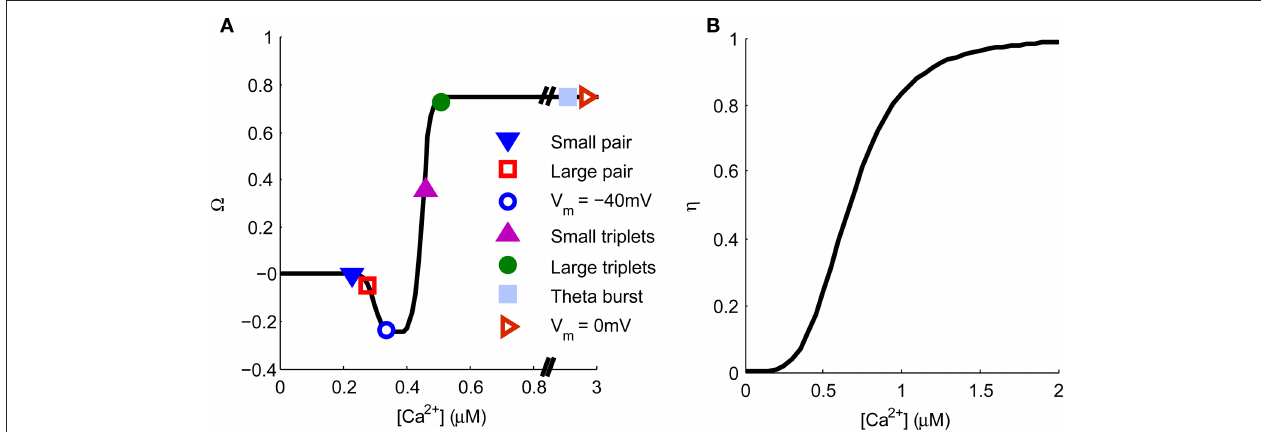
single application of the plasticity induction protocols shown in Figures 3–6 and indicate the resulting predicted synaptic weight change. (B) The η -function describes the learning rate for synaptic weight change as a function of peak spine [Ca 2 + ].